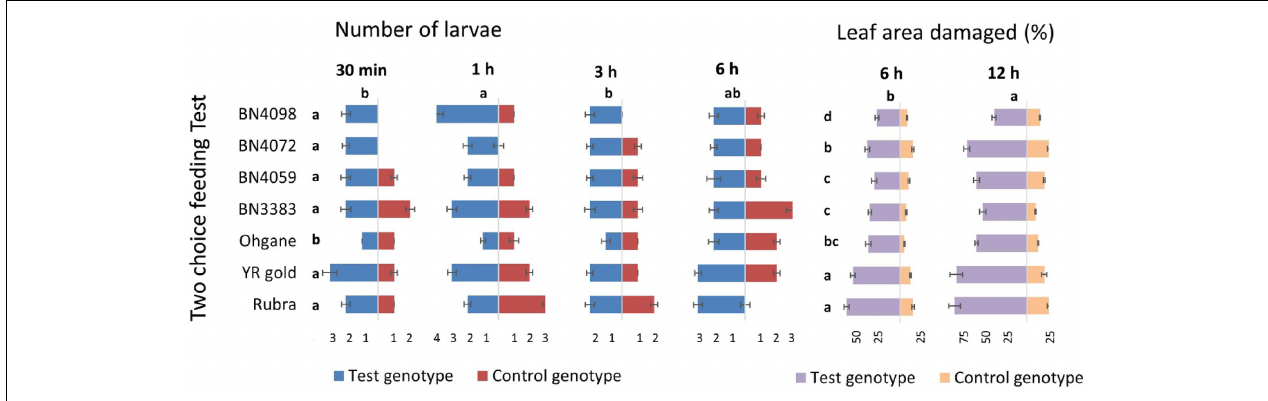
FIGURE 6 | Genotypic variation in seven test cabbage genotypes compared to the control genotype, BN4303 in terms of feeding preference and extent of damage by DBM larvae as determined by in vitro two-choice feeding test. Data recorded at different time points and presented as mean ( n = 8). The error bars indicate standard deviations. Different letters across the seven test genotypes and time-points indicate statistically significant differences ( p < 0.01) for number of larvae and percent leaf area damaged (letters given in left side of the % leaf area damaged data) as per Tukey’s pairwise